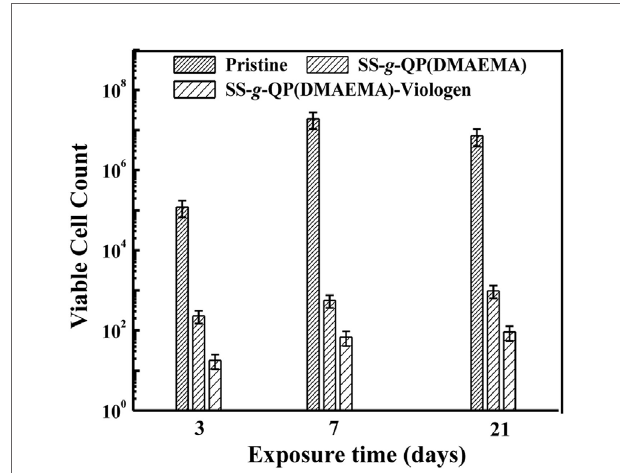
FiGURe 5 | The number of viable Desulfovibrio desulfuricans cells adhered on the pristine, the SS-g-QP (DMAEMA), and the SS-g-QP (DMAEMA)- Viologen surfaces as a function of exposure time in the D. desulfuricans inoculated SSMB medium. Reprinted with permission from Yuan et al. (2009c). Copyright 2009 Wiley Periodicals